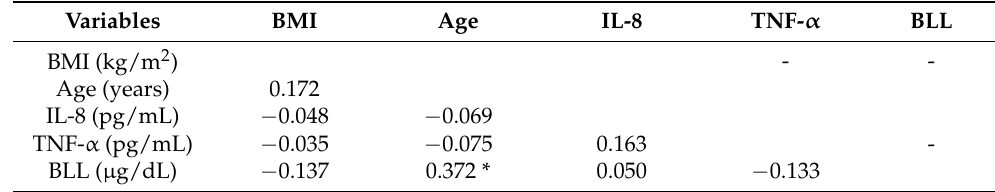
Table 3. Correlations of cytokines and independent variables in males ( n =